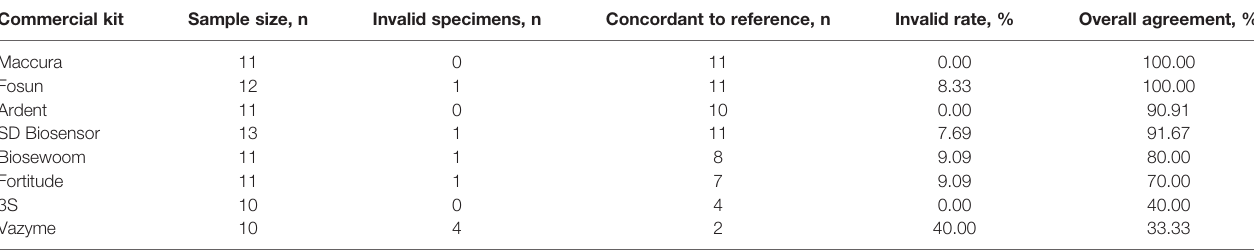
Rates of the invalid and overall agreement were calculated as compared to results from the reference, Detection Kit for 2019 Novel Coronavirus (2019-nCoV) by Da An Gene Co.